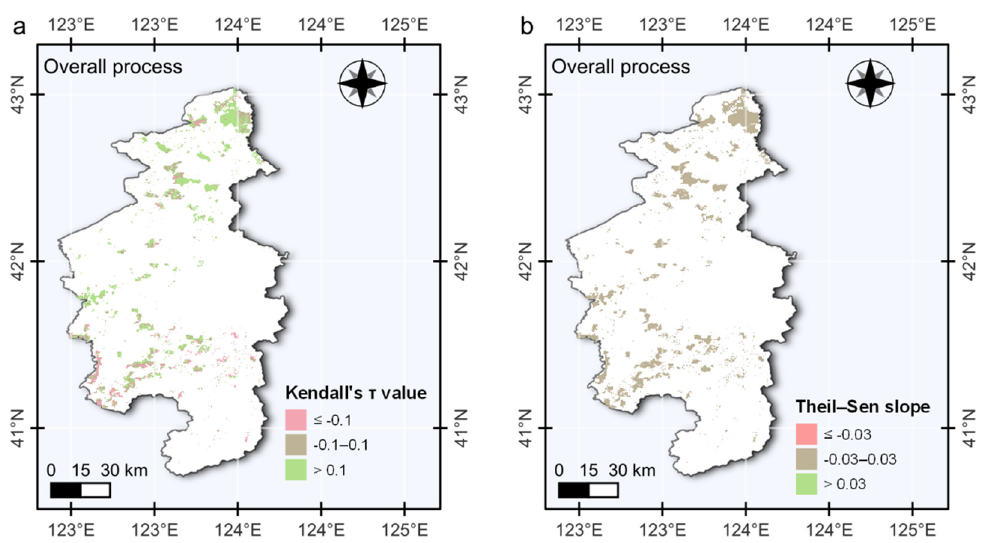
Figure A2. The overall process of the trend analysis in FC areas and an addition to Figures 7 and 8. ( a ) is the results of the M–K test, and ( b ) is the results of the Theil–Sen slope test.